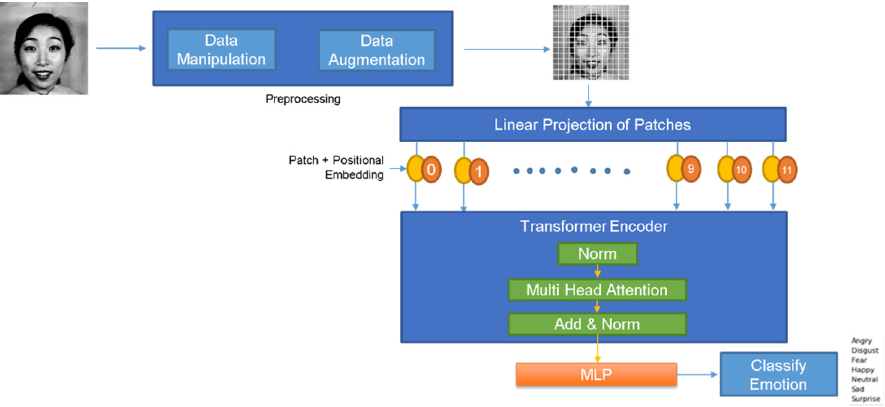
Figure 8. Architecture for emotion recognition using Vision Transformer.